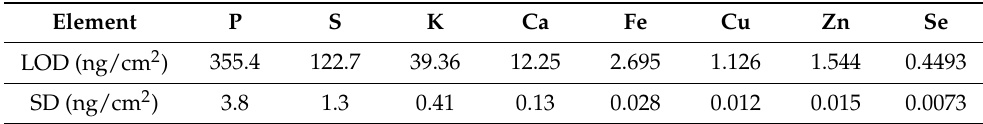
Table 1. Detection limits of analyzed elements with uncertainties calculated as standard deviation of the mean value.